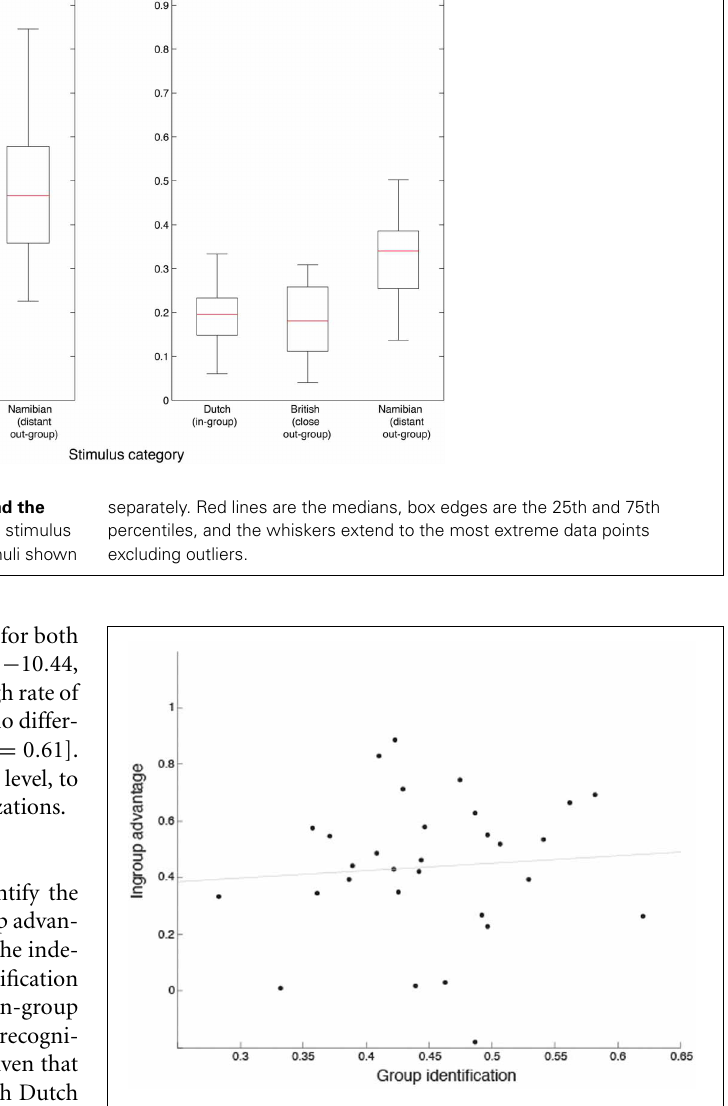
FIGURE 2 | Relationship between in-group advantage and performance on group identification in Experiment 1. In-group advantage was calculated as accuracy for Dutch (in-group) minus Namibian (out-group) stimuli, using Hu scores. Group identification scores are mean accuracy, calculated using Hu scores, across all three stimulus